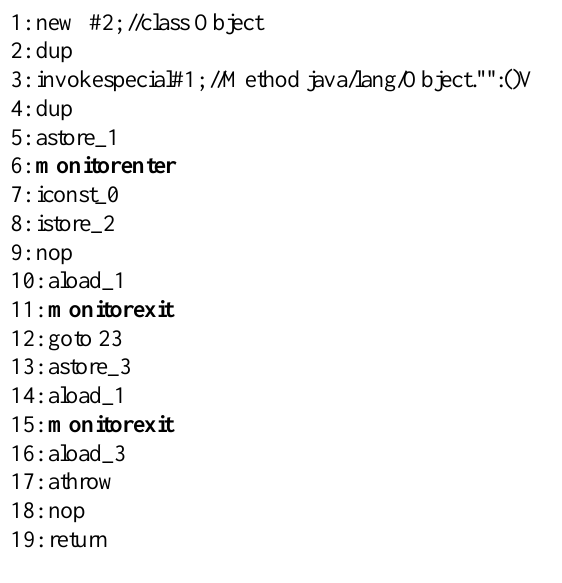
Figure 6. The bytecodes of synchronized